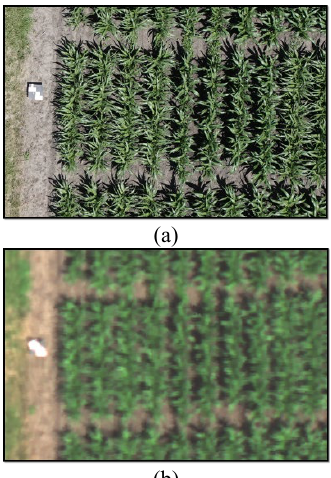
Figure 3. Sample overlapping RGB image and HS scene captured at the same height (44 m): (a) RGB frame image with 0.5 cm GSD, and (b) HS line camera scene with 4 cm GSD.